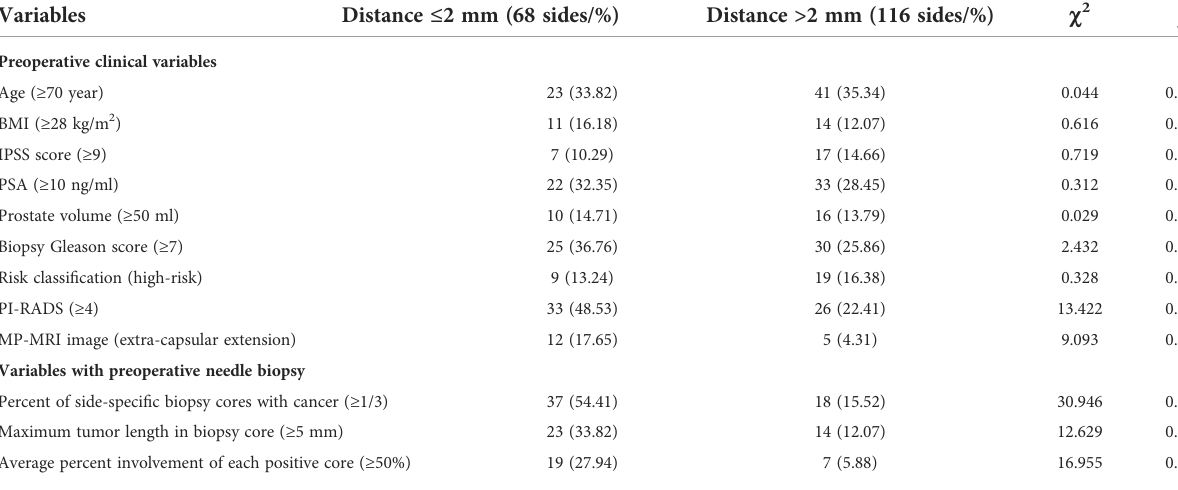
TABLE 2 Univariate analysis of preoperative variances and the N-T distance.